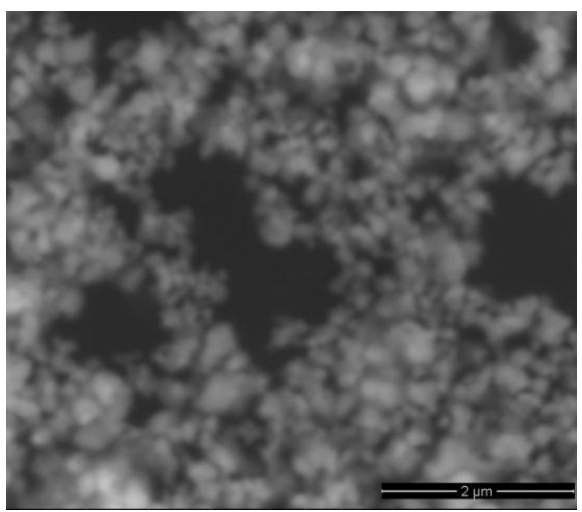
Figure 1. SEM surface morphology of TiC nanoparticles.